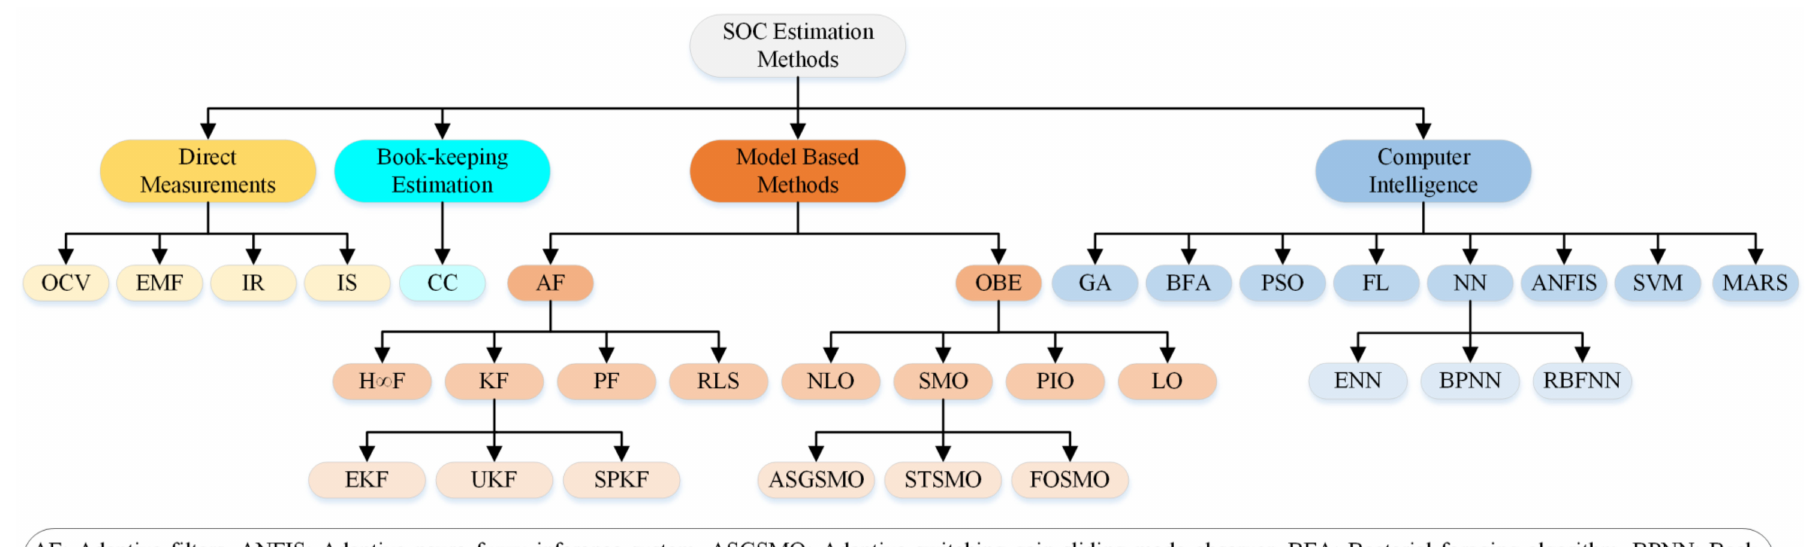
Figure 5. Classification of the SOC estimation